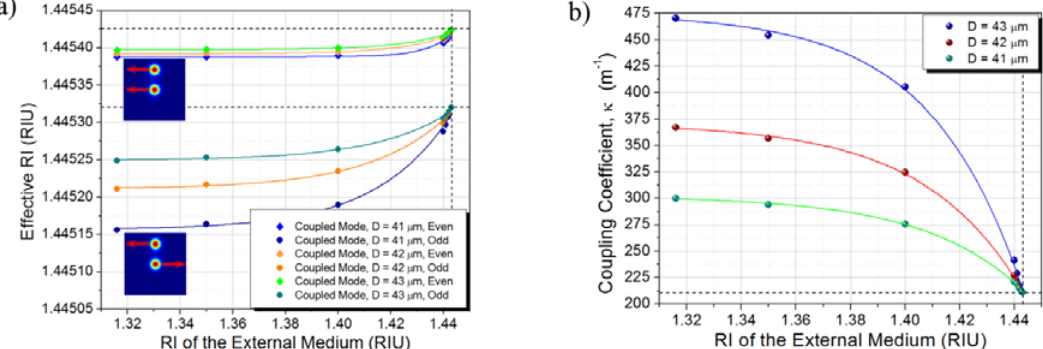
Figure 3. ( a ) ERI of the even and odd coupled modes; ( b ) Coupling coefficient as a function of the refractive index of the surrounding media for TCF diameter of 41, 42, and 43